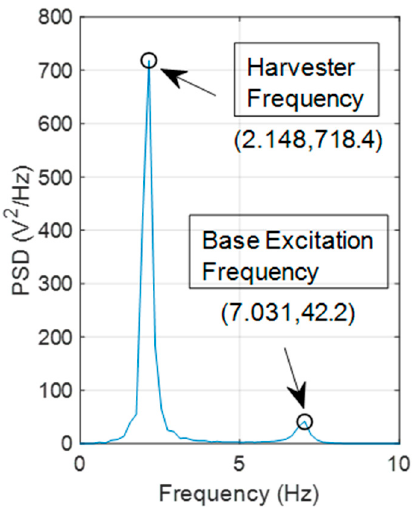
Figure 3. PSD of harvester voltage shown in Figure 2b.